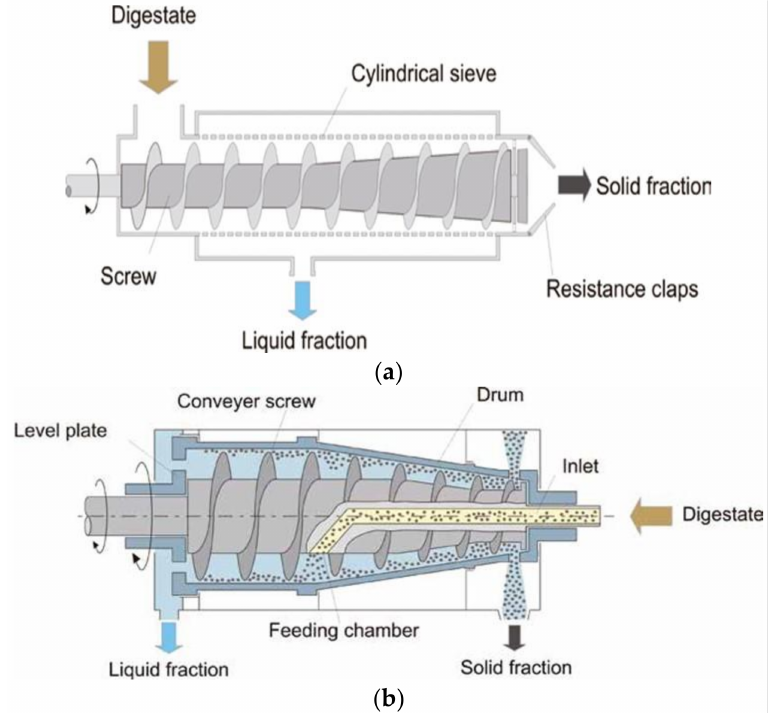
Figure 1. Simplified diagrams with digestate as a feedstock of ( a ) a screw press separator and ( b ) a decanting centrifuge separator, showing feedstock input, mode of action, separation chamber, and solid and liquid fraction outlets (reproduced by permission from Fuchs and Drosg, 2010 [37]). Most of the small particles (<1.0 mm) are therefore found in the liquid fraction after separation. The amount of solid fraction that will accumulate is dependent on the DM content and [31] found a correlation between DM concentration in feedstock (digestate) and the proportion separated into the liquid phase (Figure 2).